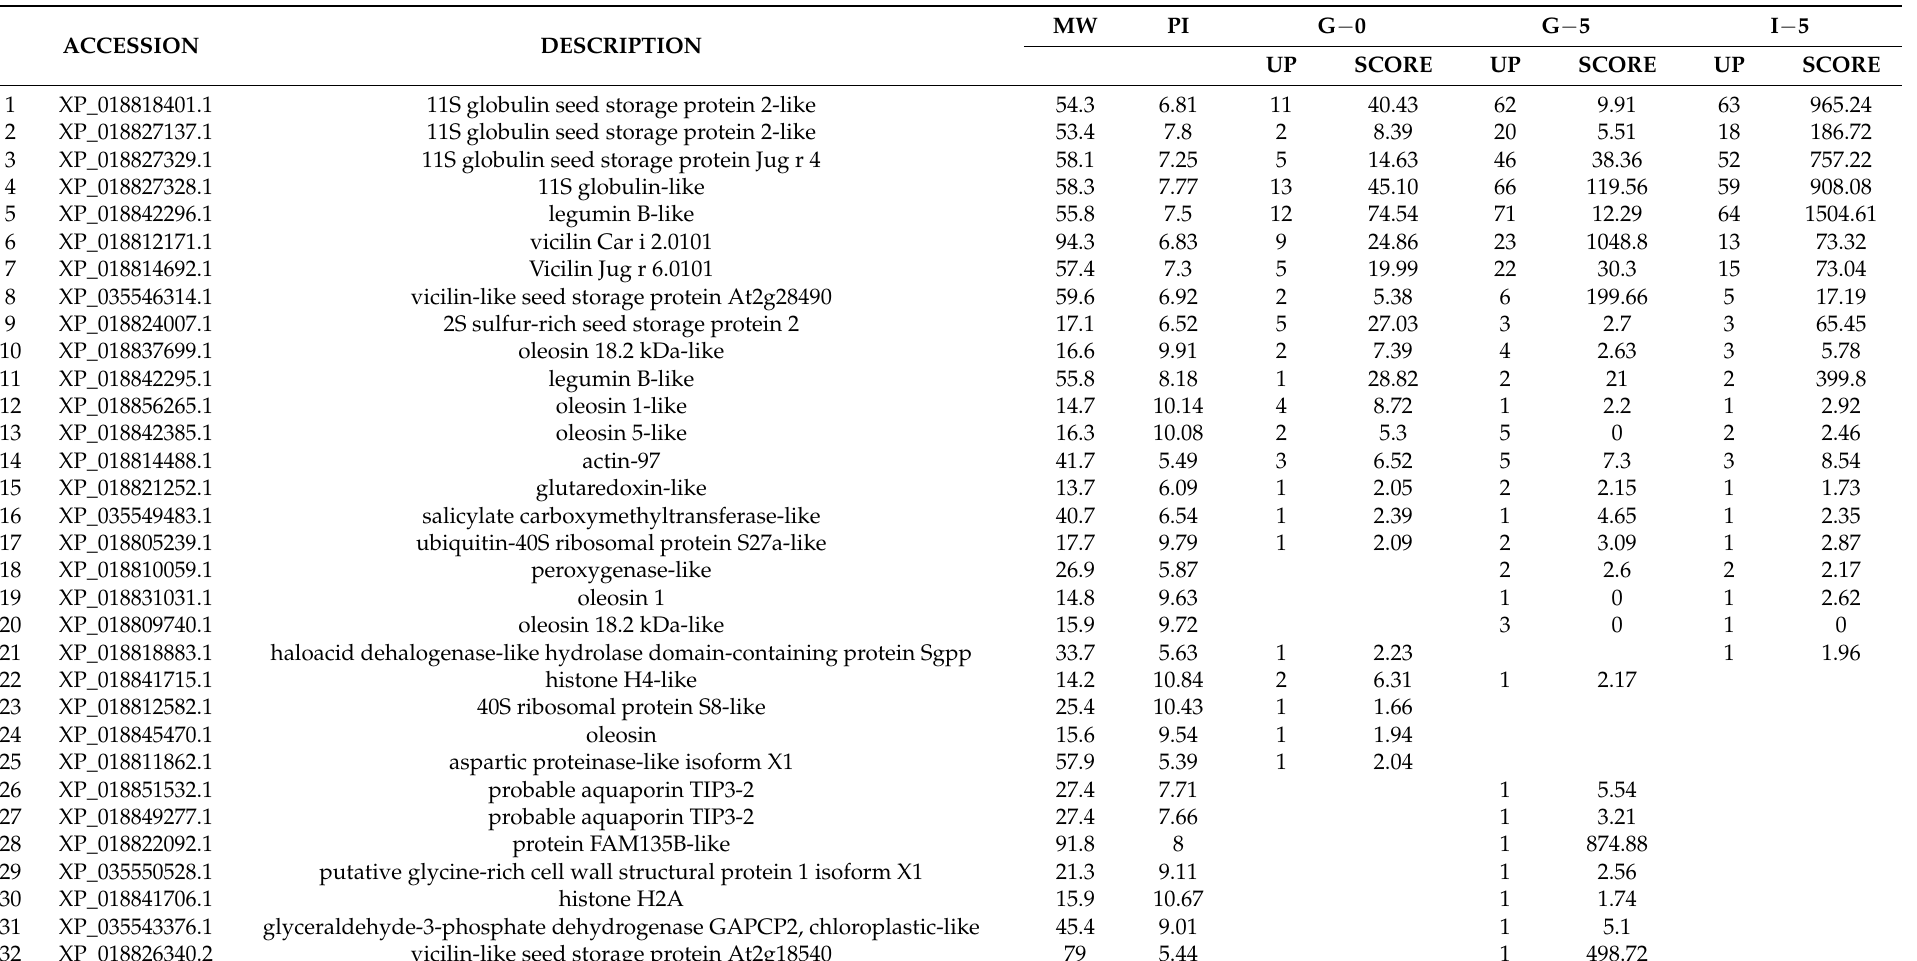
Table 2. The identification results of walnut protein digestion products (G-0, G-5, and I-5) by LC-MS/MS G-0: gastric digestion that is not oxidized; G-5: